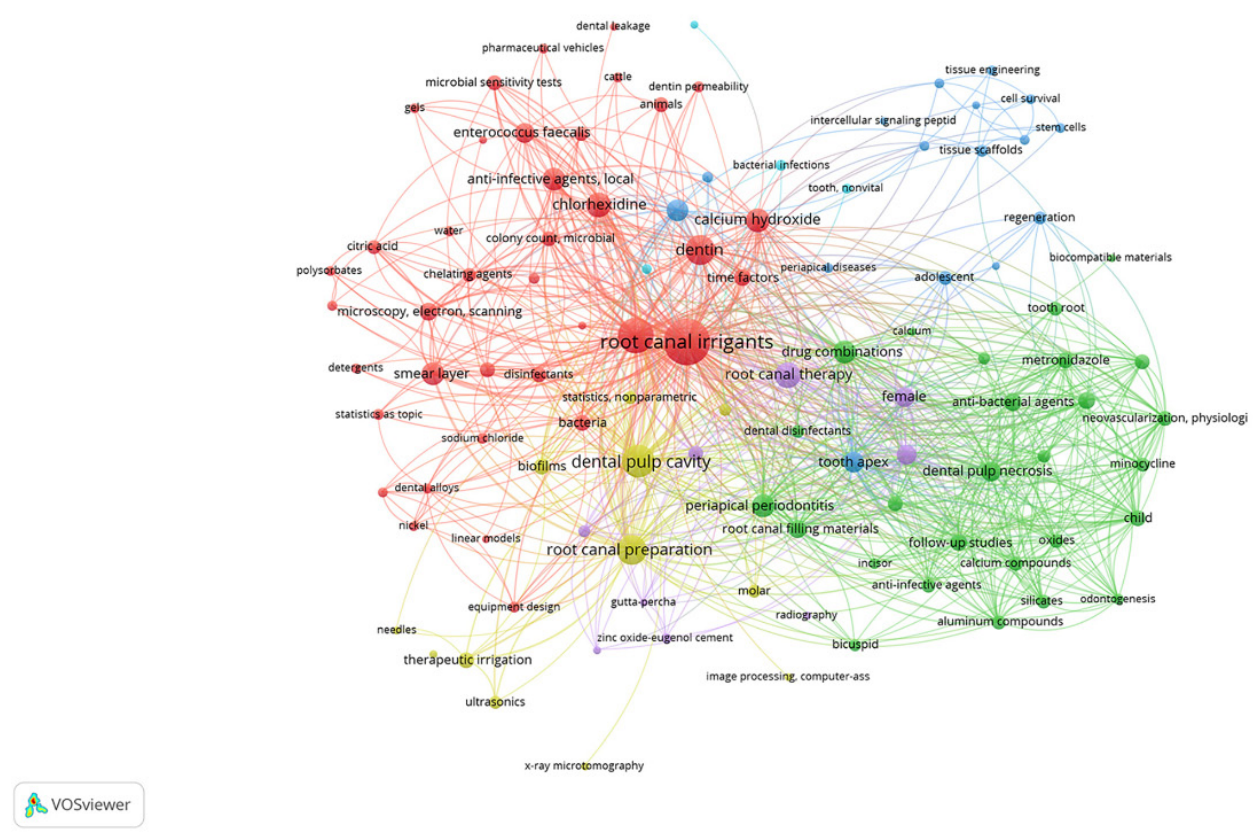
Figure 4. The network of three or more co-occurring keywords of the top 100 RCR articles in root canal disinfection. A total of 106 nodes, six clusters, and a maximum of 800 lines.